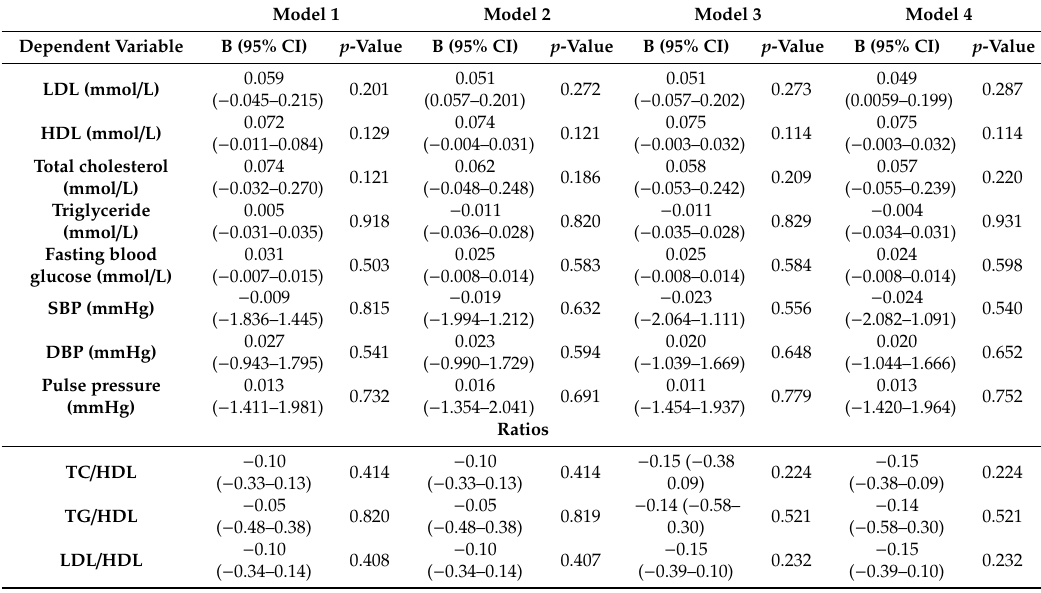
Table 3. Linear regression for the relationship between low 25(OH)D and cardio-metabolic risk